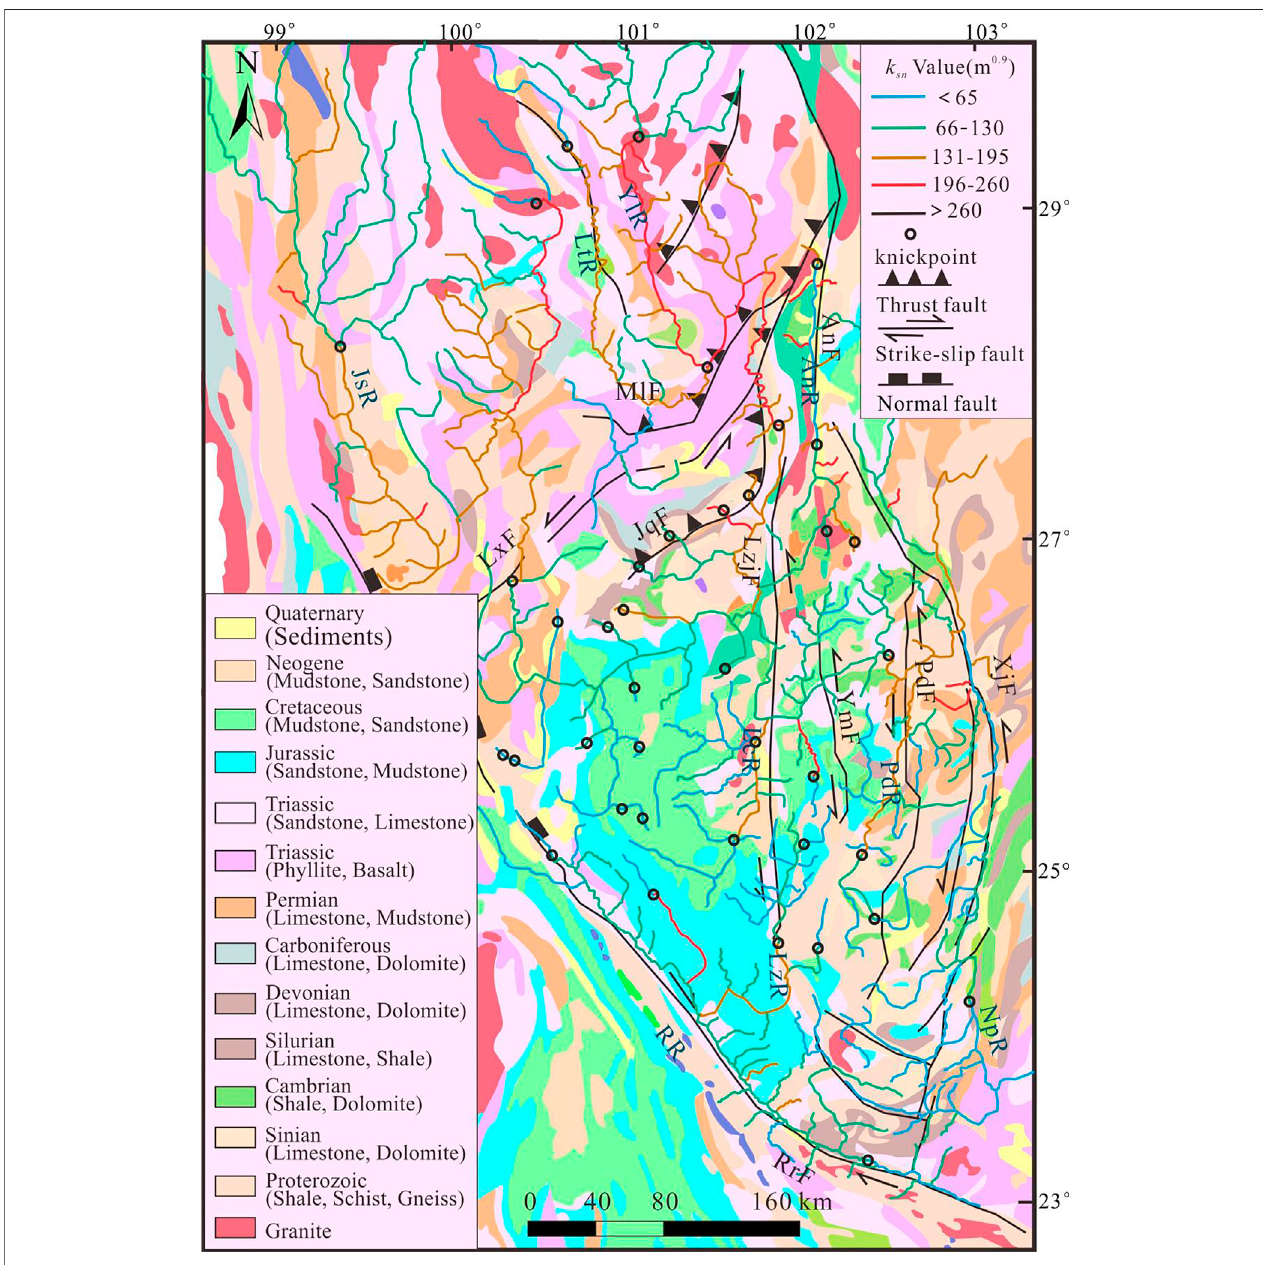
FIGURE 8 | Comparison of normalized channel steepness ( k sn ) to lithologic variability in the Central Yunnan subblock. AnF , Anninghe Fault; LxF , Lijiang – Xiaojinhe Fault; MlF , Muli Fault; JqF , Jinhe – Qinghe Fault; LzjF , Lvzhijiang Fault; YmF , Yimen Fault; PdF , Pudu Fault; XjF , Xiaojiang Fault; RrF , Red River Fault; AnR , Anning River; LcR , Longchuan River; PuR , Pudu River; LzR , Lvzhi River; NpR , Nanpan River; RrR , Red River; JsR , Jinsha River; LtR , Litang River.